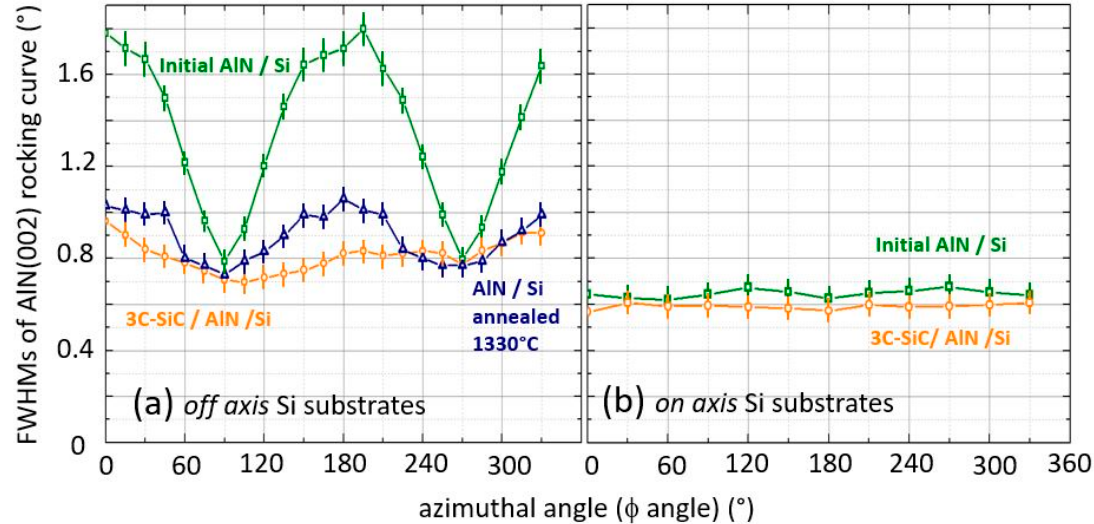
Figure 7. Azimuthal dependence of the FWHM of symmetric AlN(002) diffraction line ( a ) off axis Si substrates: AlN/Si initial templates (green square), annealed AlN/Si (blue triangles), final 3C-SiC/AlN/Si heterostructure (orange circle); ( b ) on axis Si substrates: initial AlN/Si template (green square), final 3C-SiC/AlN/Si heterostructure (orange circle). The azimuthal dependences were recorded on the same samples ( on and off axis ) before and after thermal treatment or SiC growth.